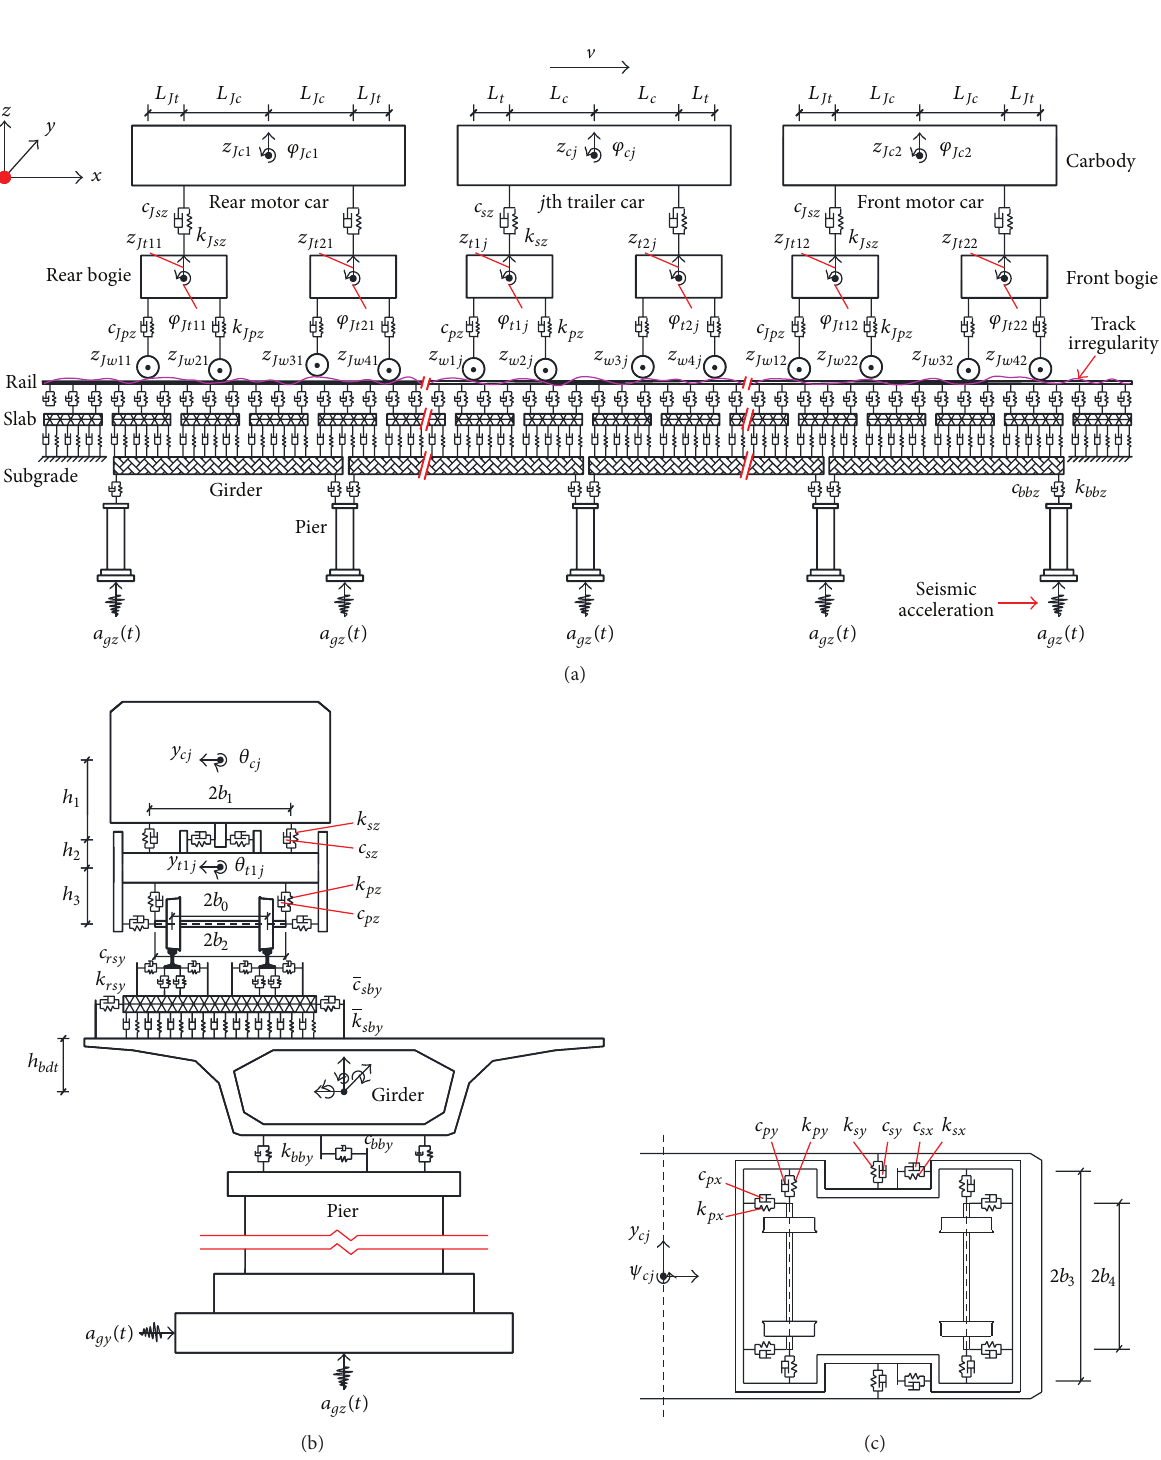
Figure 1: Three-dimensional model for the TSTBI system. (a) Frontal view. (b) Left side view (the 𝑗 th trailer car, track, and bridge). (c) Top view (half of the 𝑗 th trailer car without track and